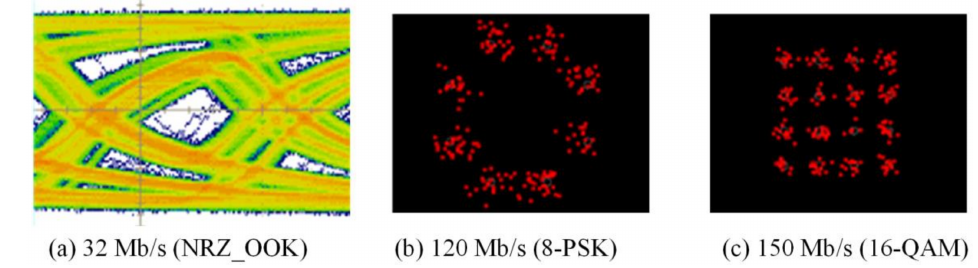
Figure 7. Micro-projection and data transmission of Red LED with bandpass filter (BER = 10 − 3 ).